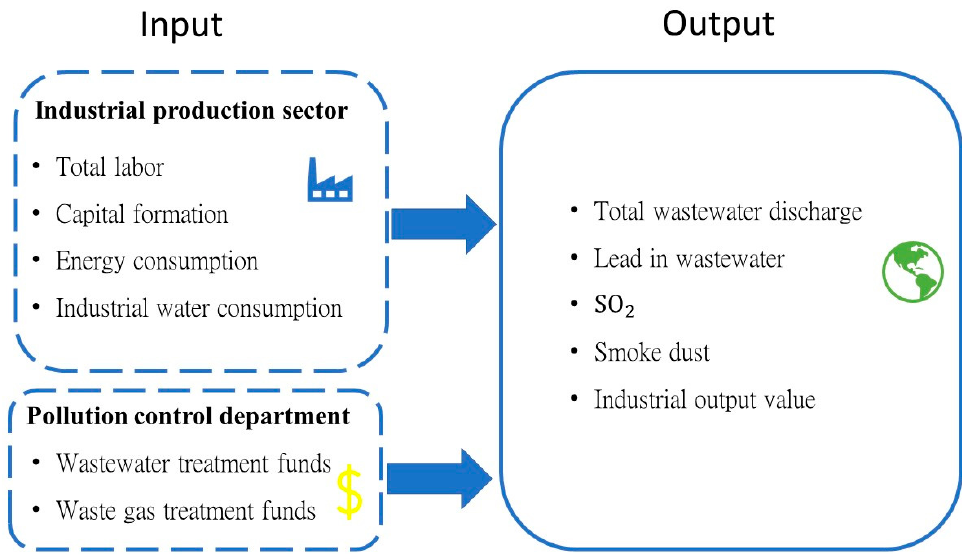
Figure 2. China’s GDP index from 1978 to 2020.